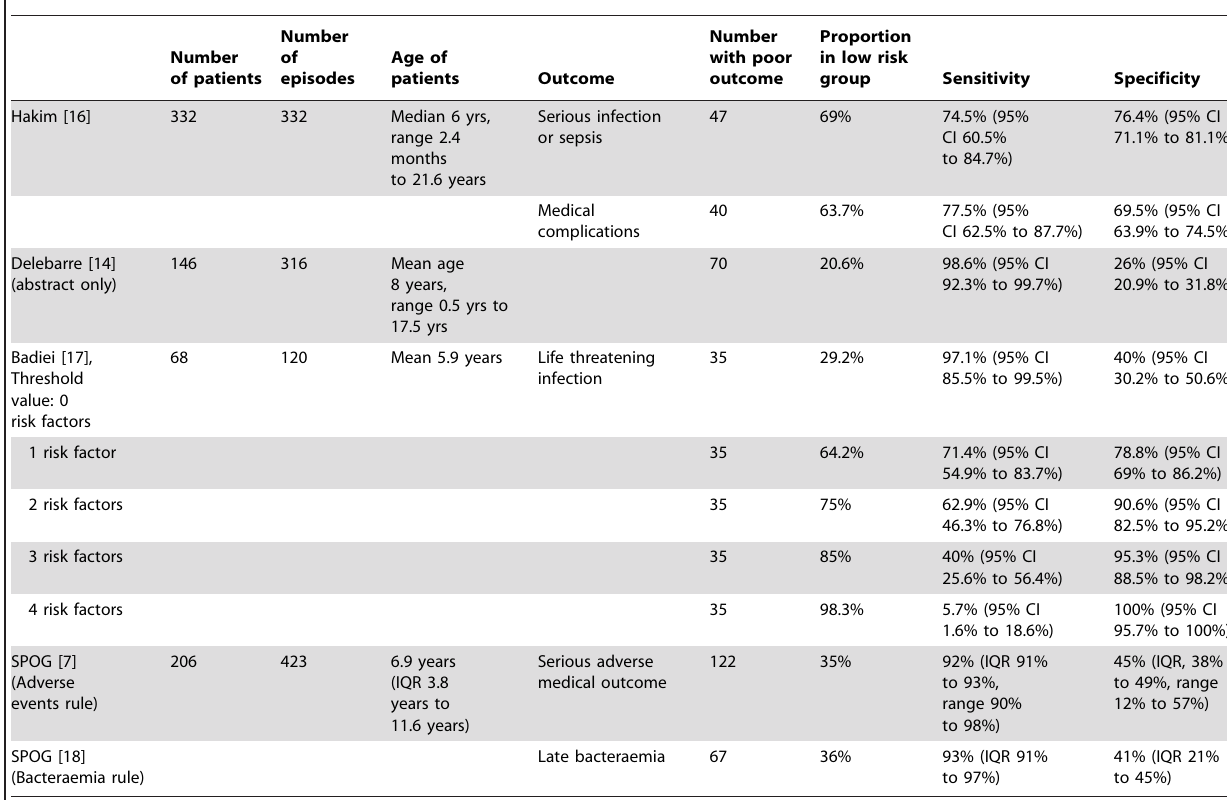
Table 2. Diagnostic test accuracy of newly described